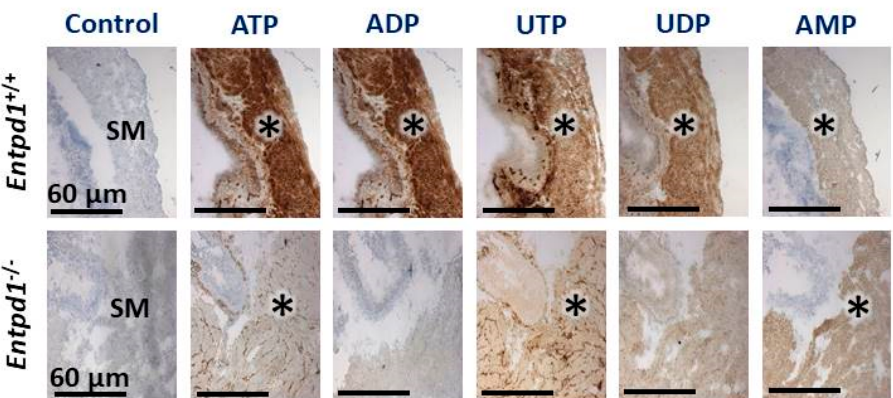
Figure 2. Comparative analysis of ectonucleotidase activity in the bladder of Entpd1 +/+ (wild type) and Entpd1 − / − (nucleoside triphosphates diphosphohydrolase 1 (NTPDase1) deficient) female mice. SM (*): smooth muscle. bar = 60 µm. Control: no nucleotides. Adenosine 5’-triphosphate (ATP), adenosine 5’-diphosphate (ADP), uridine 5’-triphosphate (UTP), uridine 5’-diphosphate (UDP), and adenosine 5’-monophosphate (AMP) were used as substrate at a concentration of 100 µM. Experiments were done on three mice of each group.